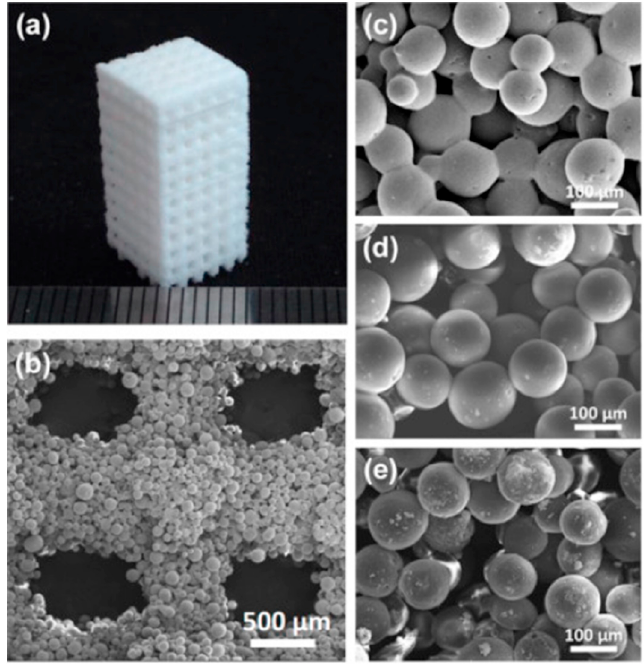
Figure 6. ( a ) Sintered cuboid porous scaffold with 3D orthogonal periodic porous architectures (length/width 8.8 mm, height 18.4 mm, pore size 800 µm). ( b ) SEM image of the pore morphology obtained in a 10% HA/PCL scaffold. ( c – e ) SEM images of the sintered PCL ( c ) and composite microspheres with increasing content of HA, ( d ) 10% HA/PCL, and ( e ) 20% HA/PCL. Figure reprinted from Colloids and Surfaces B: Biointerfaces , 135, Du, Y., Liu, H., Shuang, J., Wang, J., Ma, J., and Zhang,